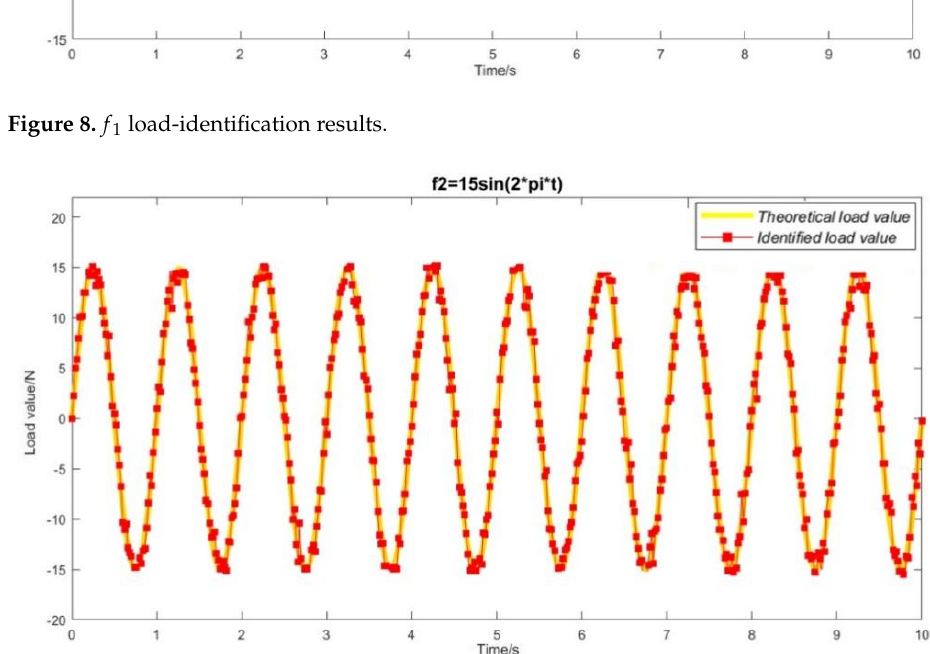
Figure 9. f 2 load-identification results.